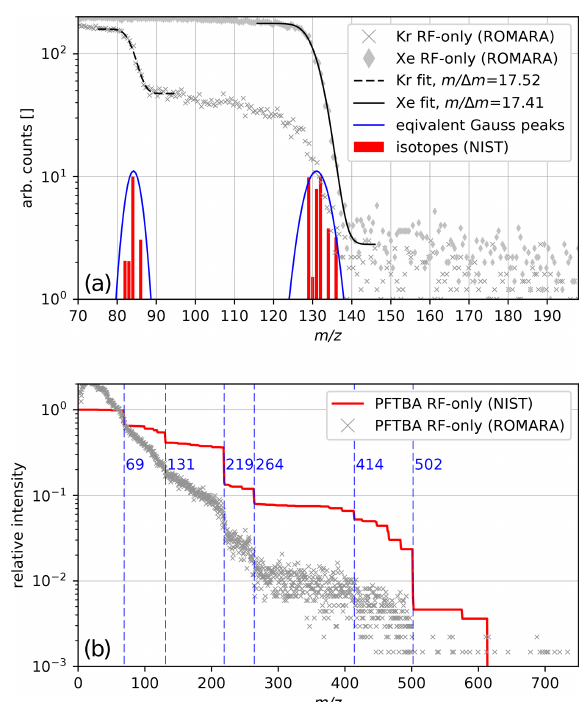
Figure 5. (a) RF-only spectrum of Kr and Xe, CDF fits and equiva- lent Gauss peaks. (b) ROMARA RF-only measurement of PFTBA and NIST data of